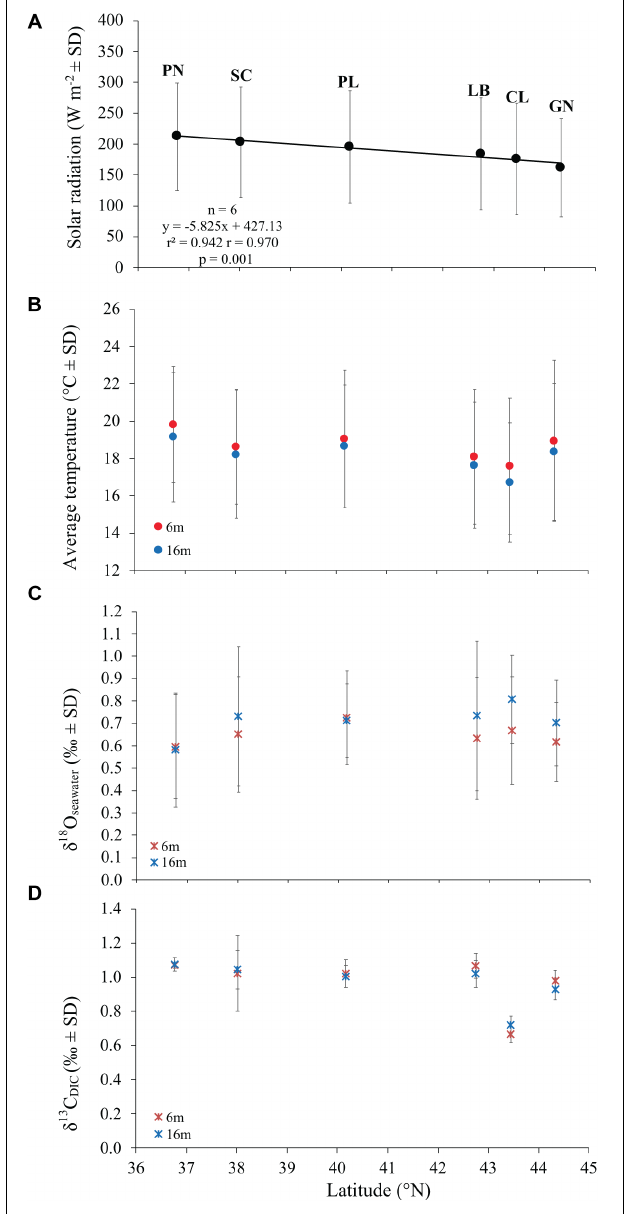
FIGURE 2 | The relation between average solar radiation values at sea surface (A) , temperature (B) , δ 18 O seawater (C) , and δ 13 C DIC (D) with latitude at 6 and 16 m depth in 6 sites along the west coast of Italy ( ∼ 850 km